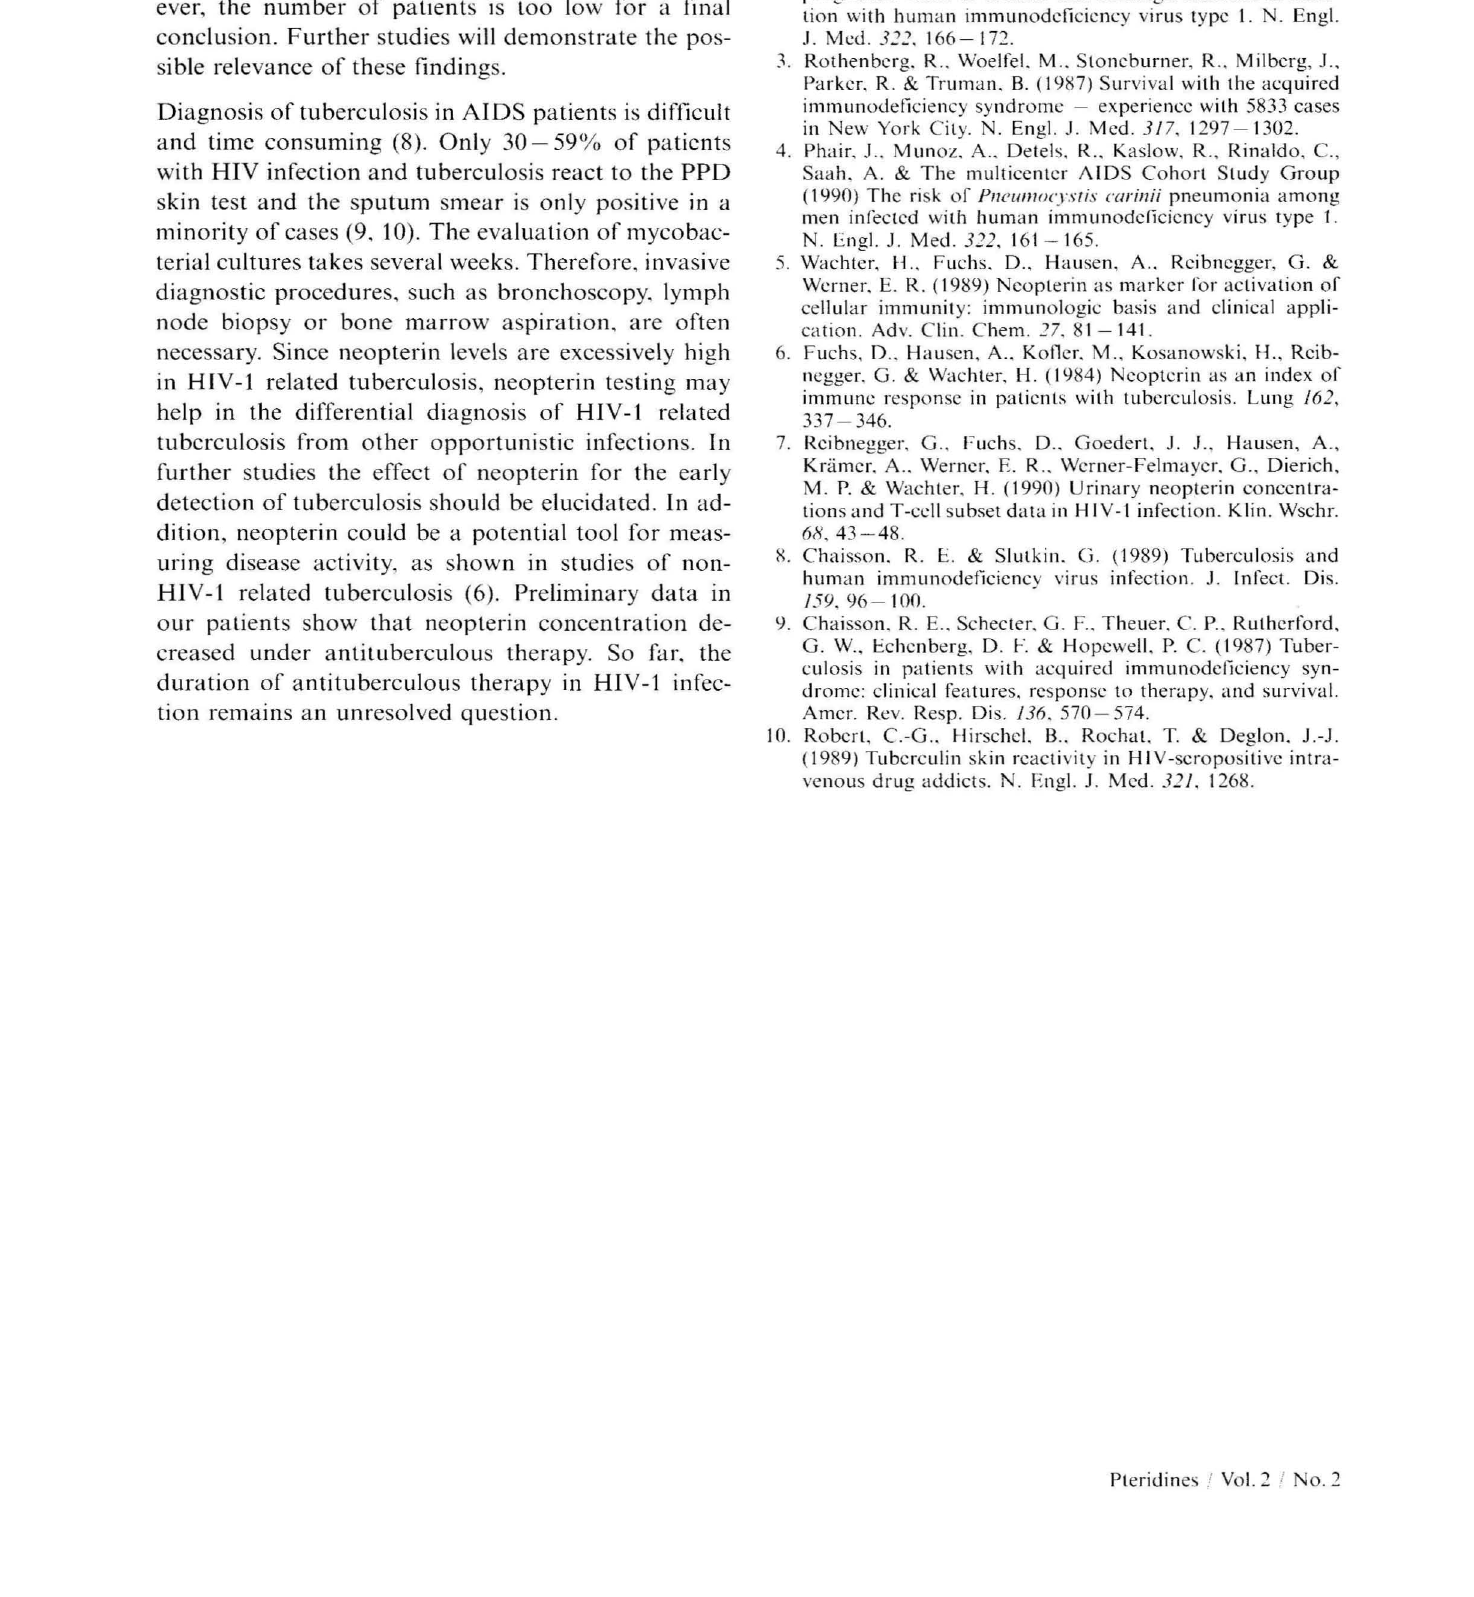
further studies the effect of neopterin for the early detection of tuberculosis should be elucidated. In ad dition, neopterin could be a potential tool for meas uring disease activity, as shown in studies of non HIV-t related tuberculosis (6). Preliminary data in our patients show that neopterin concentration de creased under antituberculous therapy. So far, the duration of antituberculous therapy in HIV-l infec tion remains an unresolved